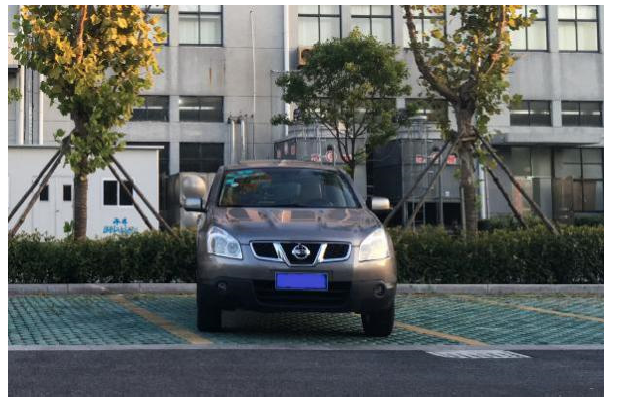
Figure 13. Test vehicle.